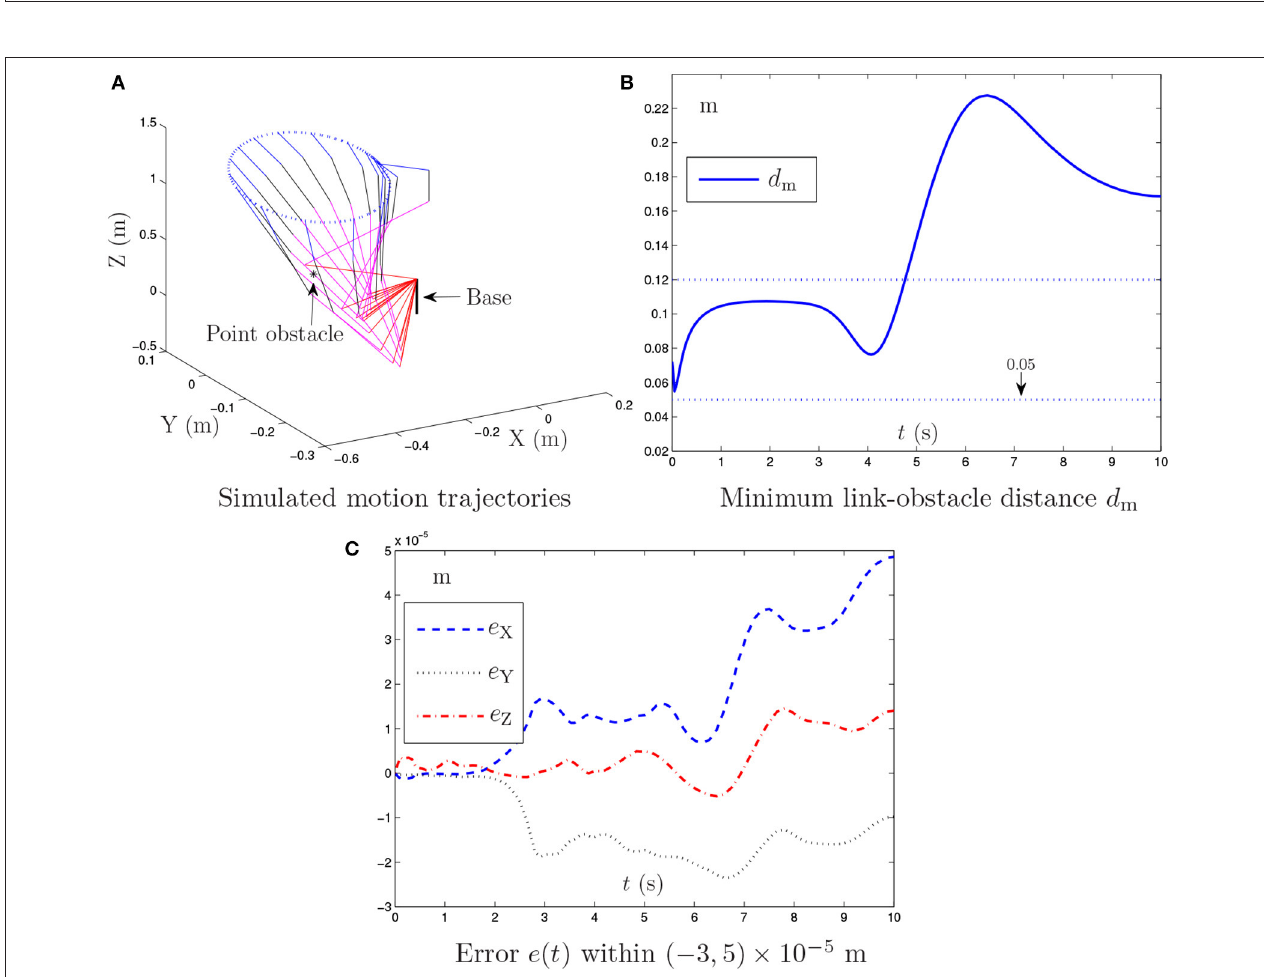
Frontiers in Neurorobotics | www.frontiersin.org